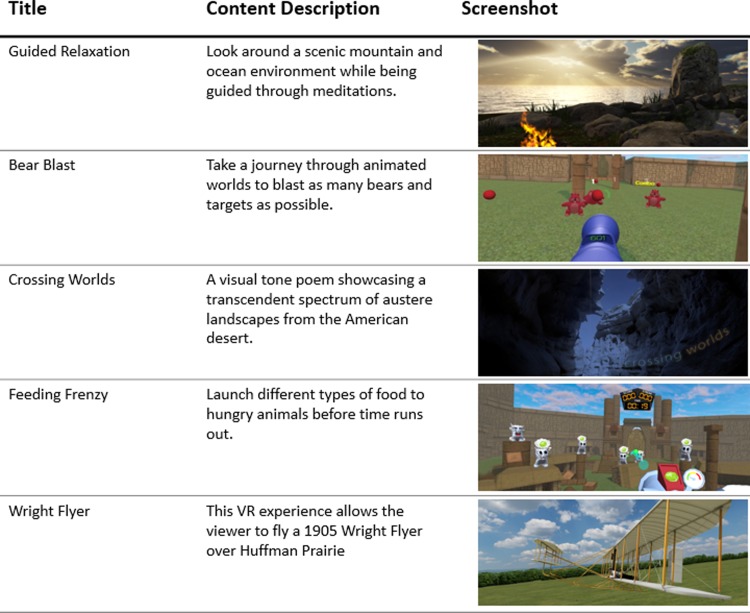
Titles, descriptions, and screenshots of VR experiences available to patients in the experimental group.Complete list of content provided in supplemental materials (S1 Fig). Republished under a CC BY license, with permission from AppliedVR, original copyright 2016.